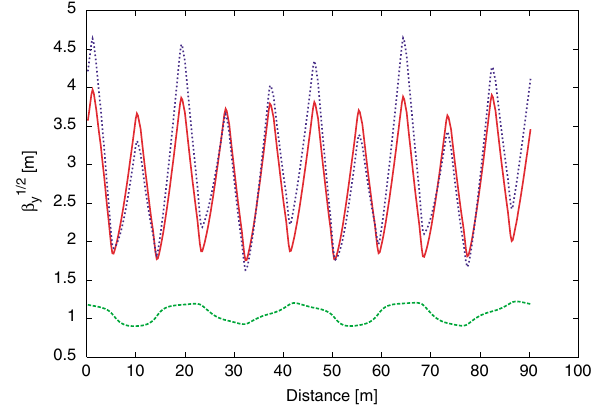
FIG. 16. (Color) The square root of the perturbed vertical betatron amplitude function (blue dashed line), for a beam with high intensity ( 4 : 37 (cid:14) 10 13 particles) in the PSR at LANL, is compared with the square root of the intrinsic betatron amplitude function (solid red line). The ratio of these two betatron amplitude functions, shown as the dashed (green) line, is the reduced envelope radius R defined in Eq. (A3). Note that the average of R is slightly larger than